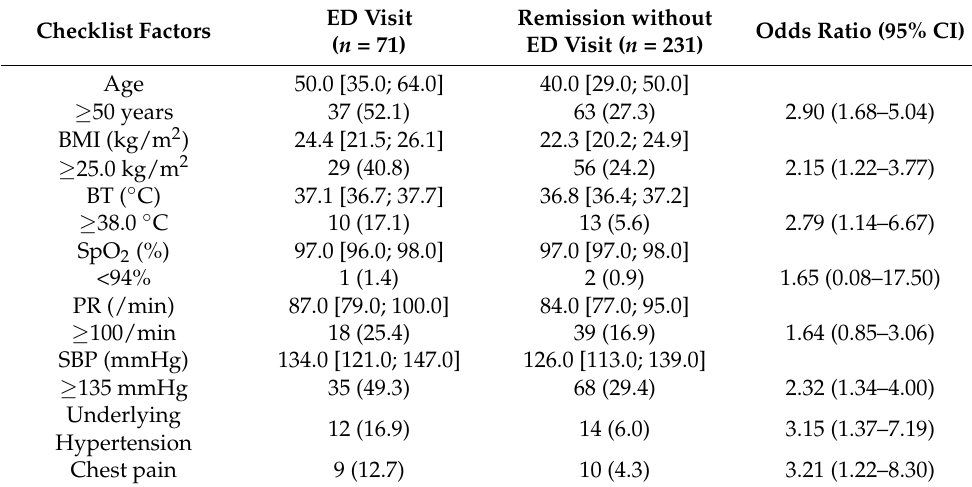
Table 3. Checklist factors and ED visits during isolation in facilities or at